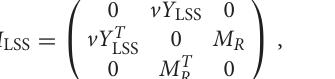
M R ) and hierarchical in the right ( M R 2 = 1